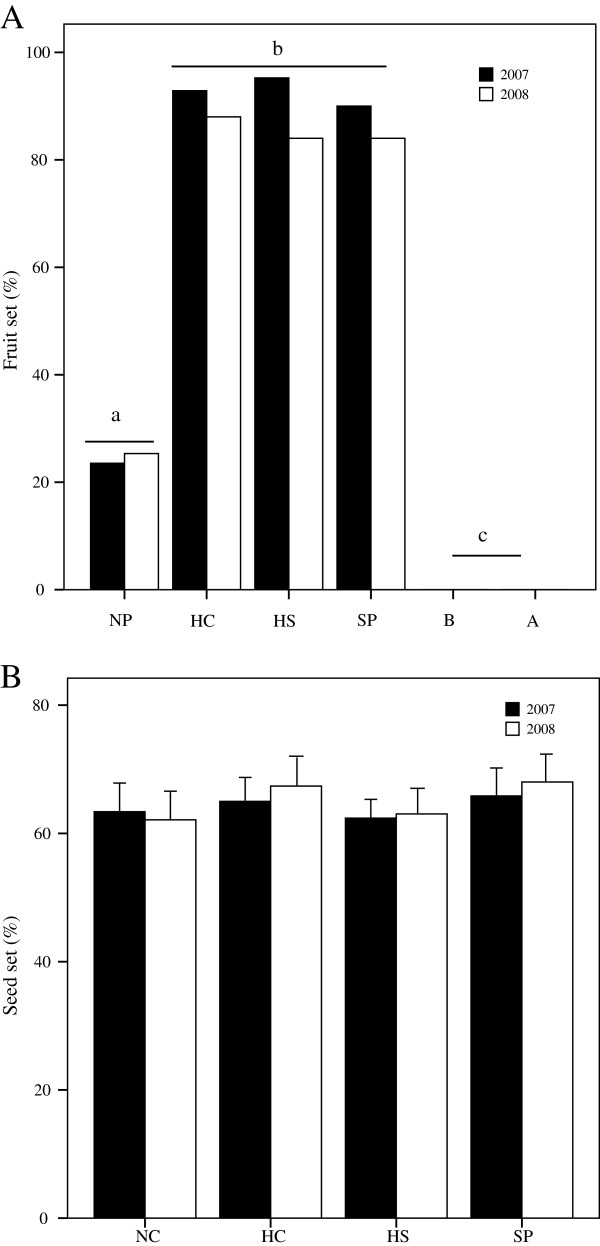
Comparison of fruit set (A) and seed set (B) among pollination treatments in the population HLG. NP, natural pollination; HC, hand cross-pollination; HS, hand self-pollination; SP, supplemented pollination; B, bagged, automatic self-pollination; A, apomixis. Bars with different letters differ statistically at P < 0.05.